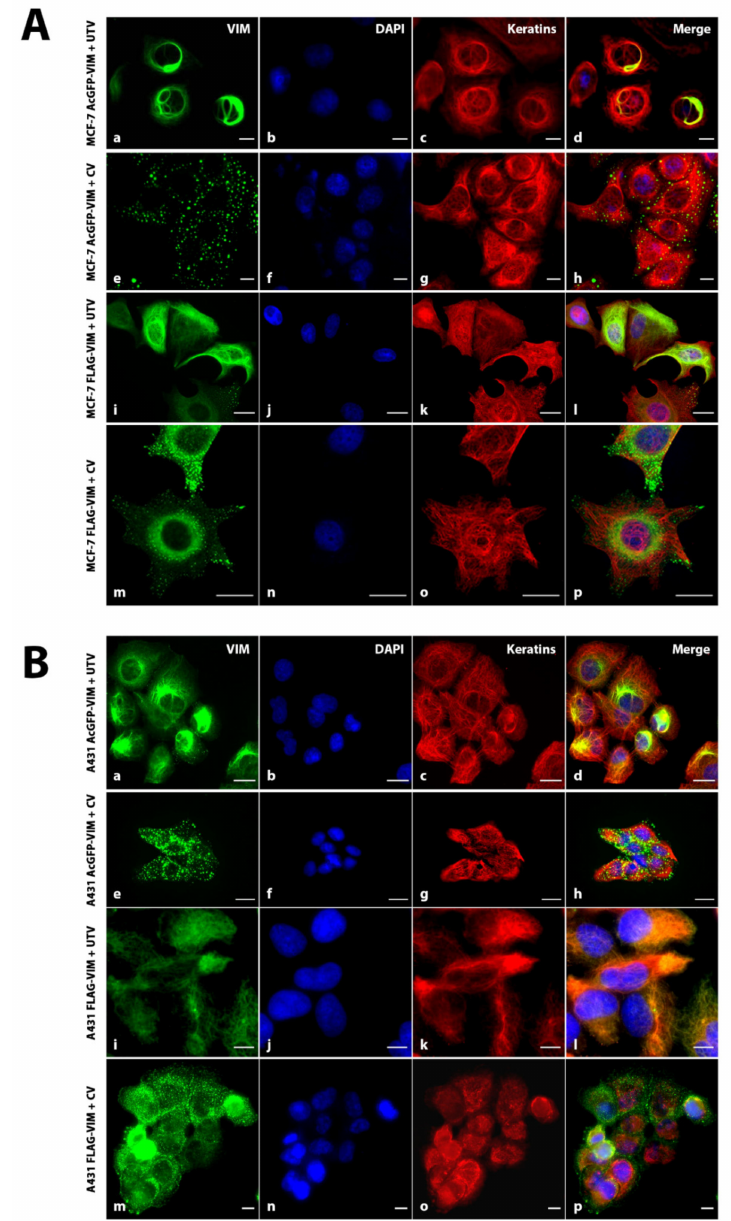
Figure 6. Aggregates of N-terminally tagged vimentin can be reversed by untagged vimentin (UTV). ( A ) MCF-7 and ( B ) A431 cells expressing AcGFP-VIM and FLAG-VIM vimentin aggregates